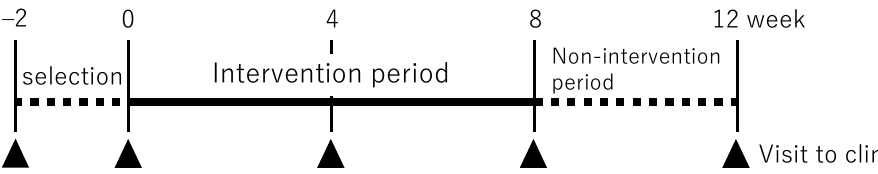
Figure 1. Intervention test schedule. An 8–week intake period and a 4–week non-intake period were established. Various tests were performed at 0, 4, 8, and 12 weeks.